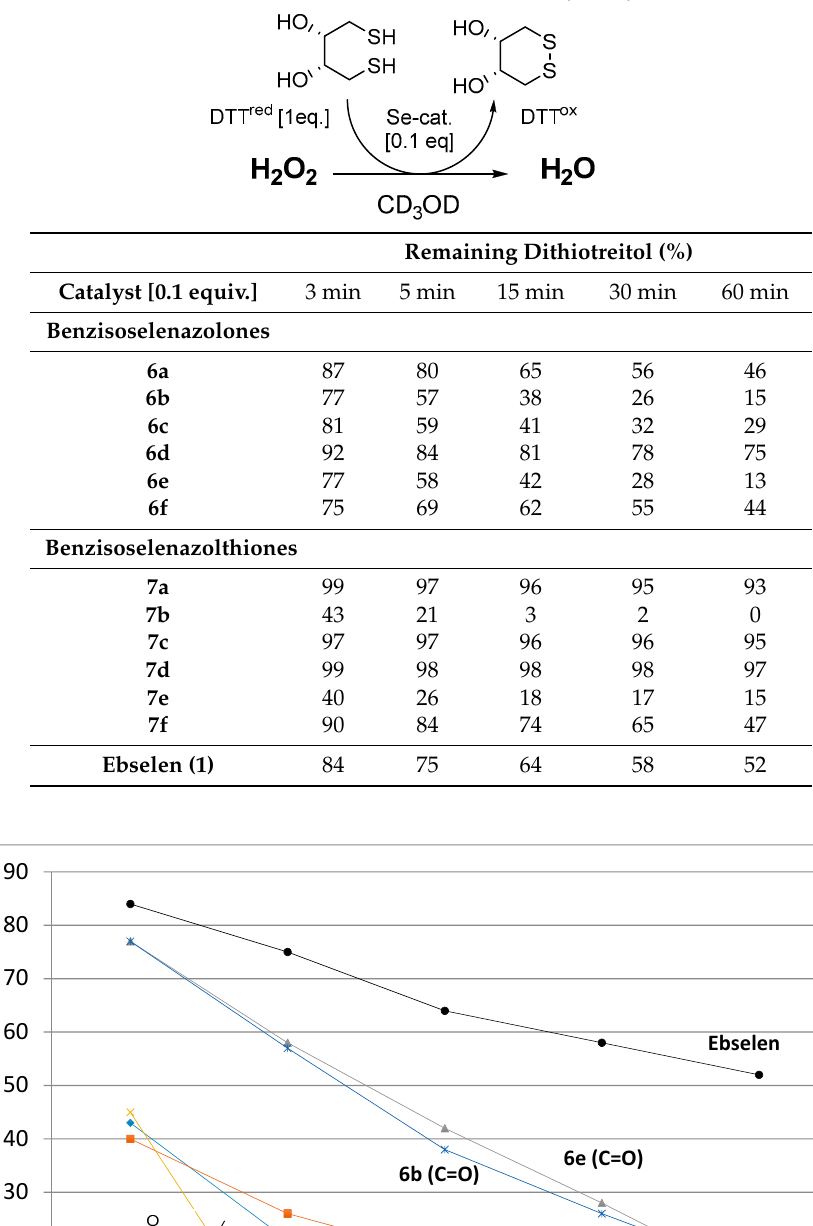
Table 2. Results of the antioxidant activity assay.